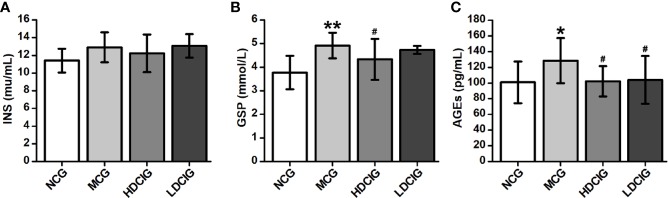
Effects of D-chiro-inositol (DCI) on serum indices in db/db mice. (A) The result of insuin (INS). (B) The result of glycated serum proteins (GSP). (C) The result of advanced glycation end products (AGEs). All values are expressed as means ± SD, n=10. *P < 0.05, **P < 0.01 vs. normal control goup (NCG) mice; #P < 0.05 vs. model control group (MCG) mice.